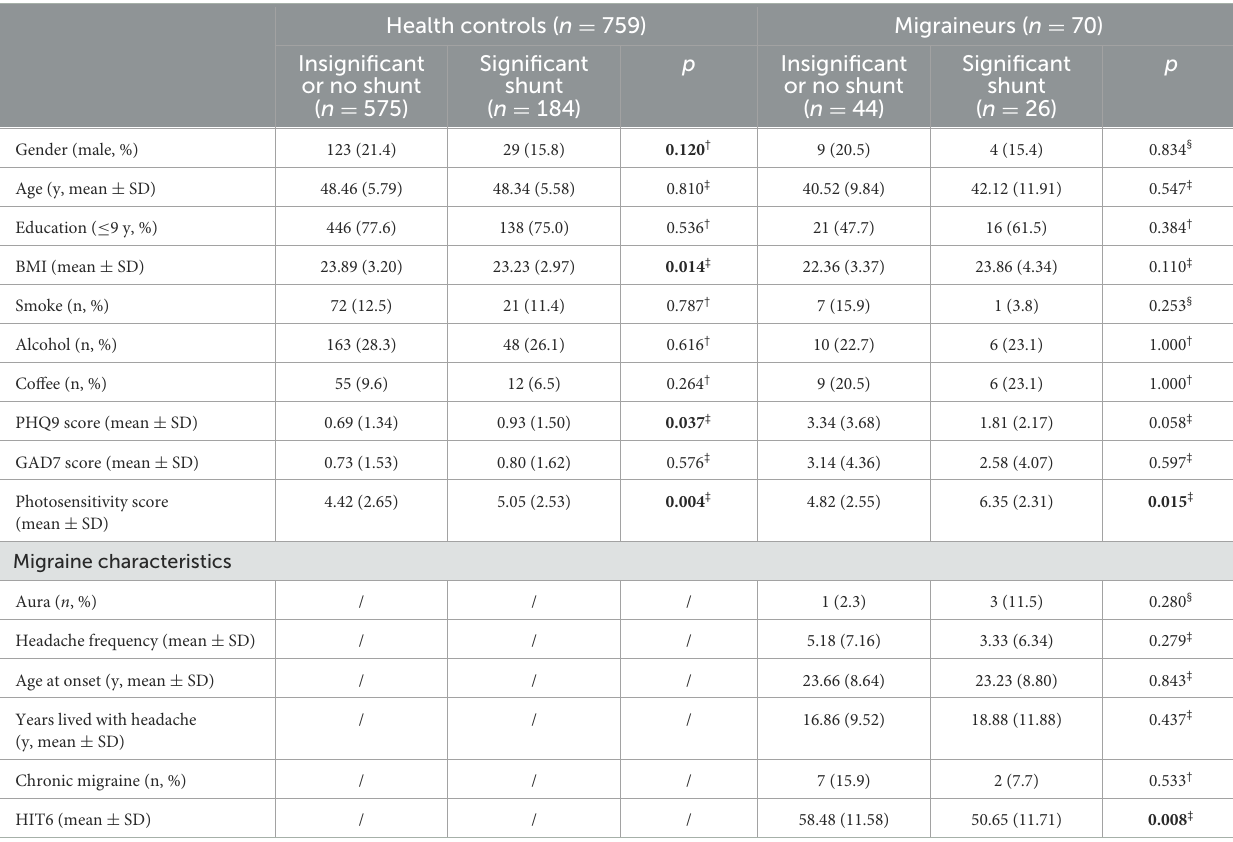
TABLE 2 High photosensitivity score in participants with significant RLS in the group of healthy controls or group of migraineurs.